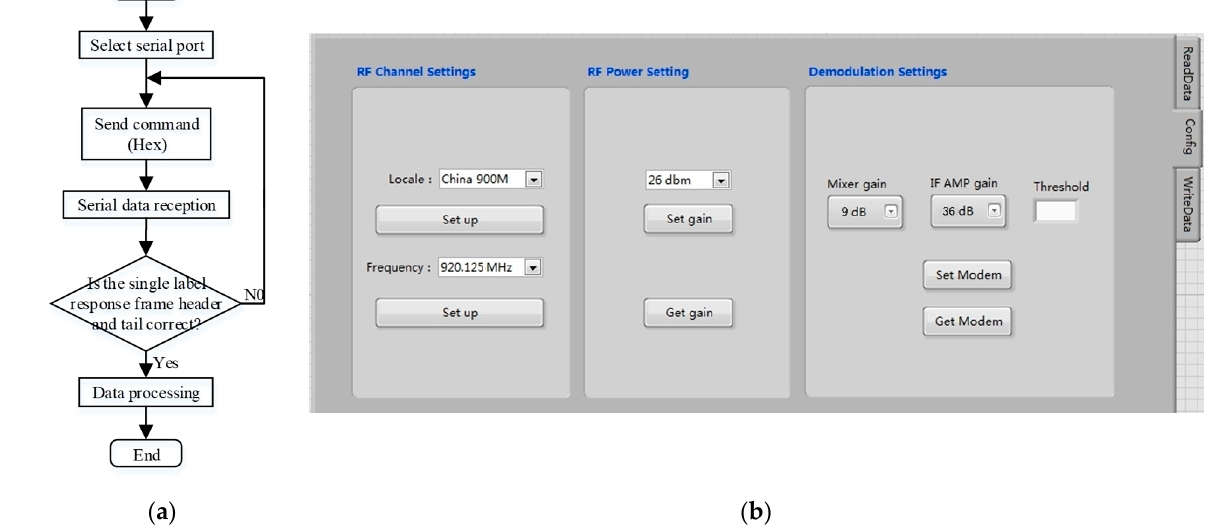
Figure 10. ( a ) Communication process of reader configuration platform; ( b ) Interface of reader configuration platform.